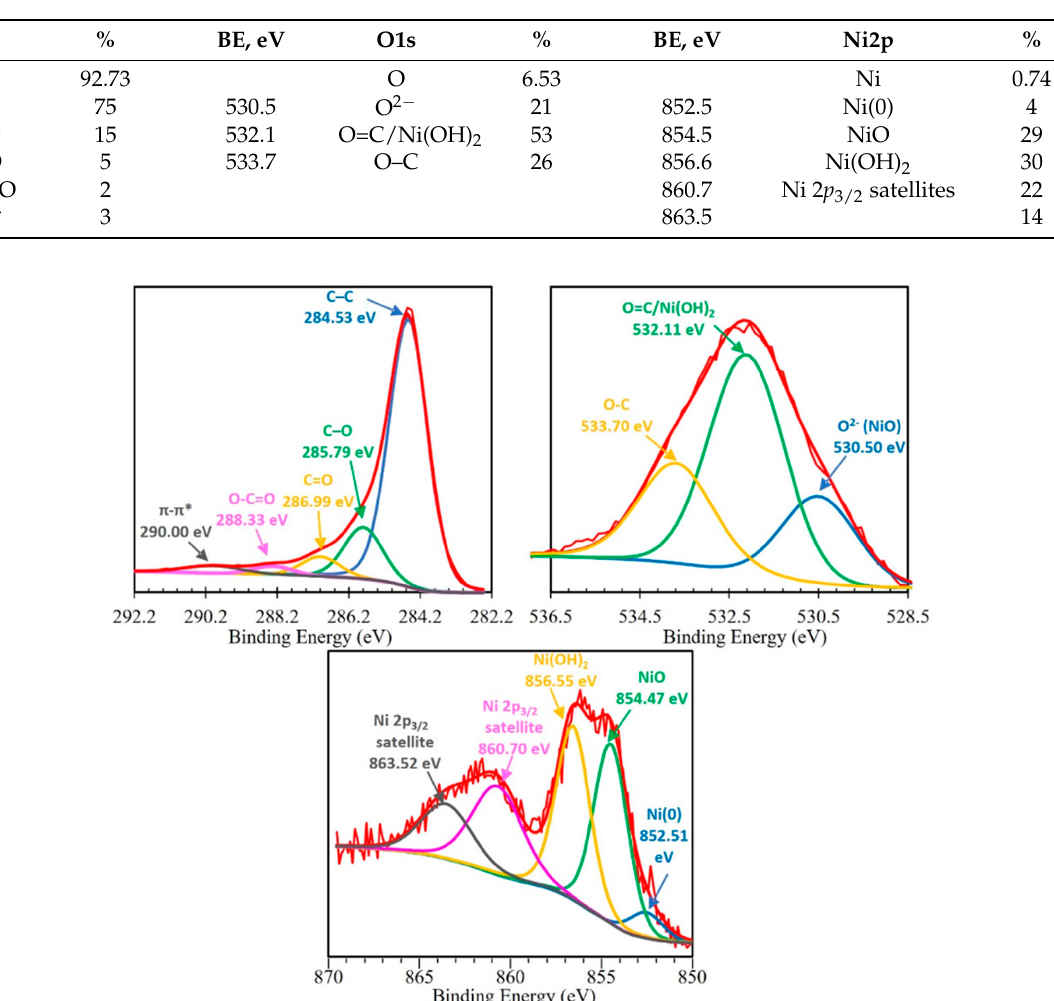
Table 2. Results of the deconvolution of the XPS core-level spectra for C1s, O1s, and Ni2p, and the element content in atomic % for TPNi.